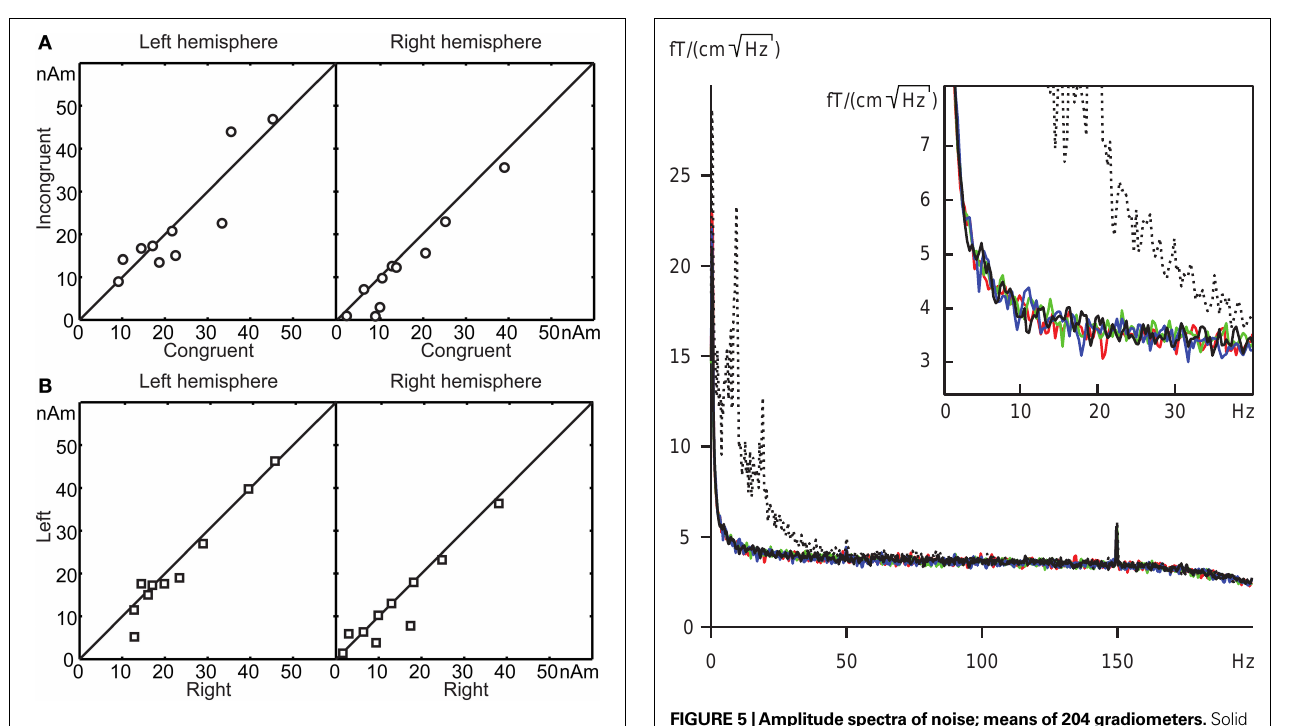
FIGURE 4 | (A) Mean source strengths from 50 to 250 ms after the second vowel onset of each subject in incongruent audiovisual condition, plotted against mean source strengths in congruent audiovisual condition. (B) Similar comparison, with mean source strengths in left viewing plotted against mean source strengths in right viewing.